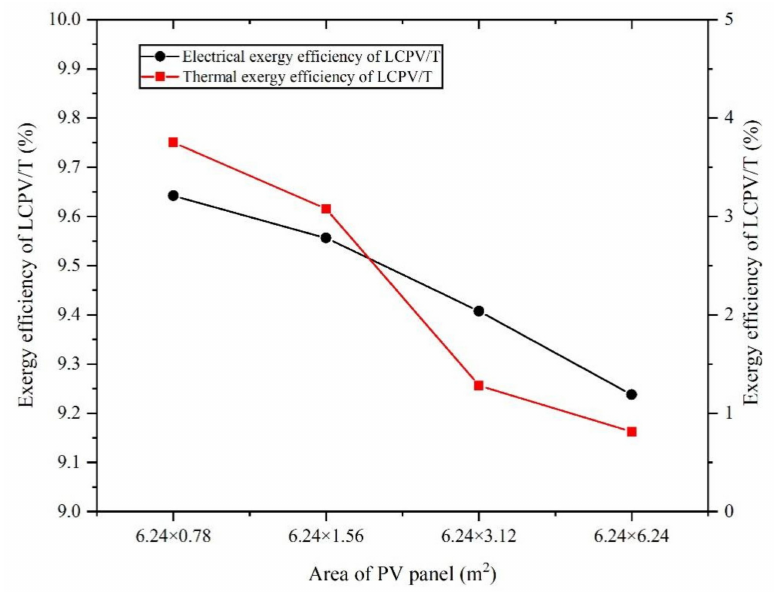
Figure 25. Electrical exergy efficiency and thermal exergy efficiency of the LCPV/T under variable PV cell area.